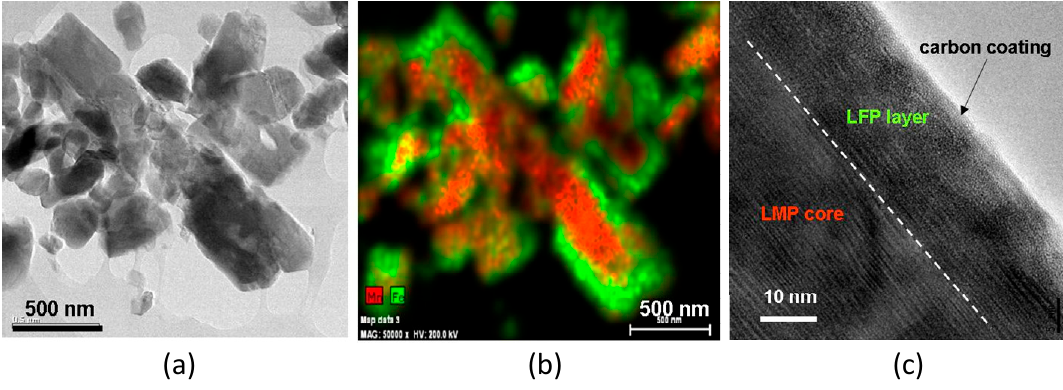
Figure 2. ( a ) STEM image of the LiMnPO 4 –LiFePO 4 (LMP–LFP) blend particle showing the different layers; ( b ) The typical EDX map of LMP (in red)–LFP (in green) particle; ( c ) HRTEM image showing the lattice fringes with the sharp interface between LiMnPO 4 and LiFePO 4 and the continuous, carbon layer.